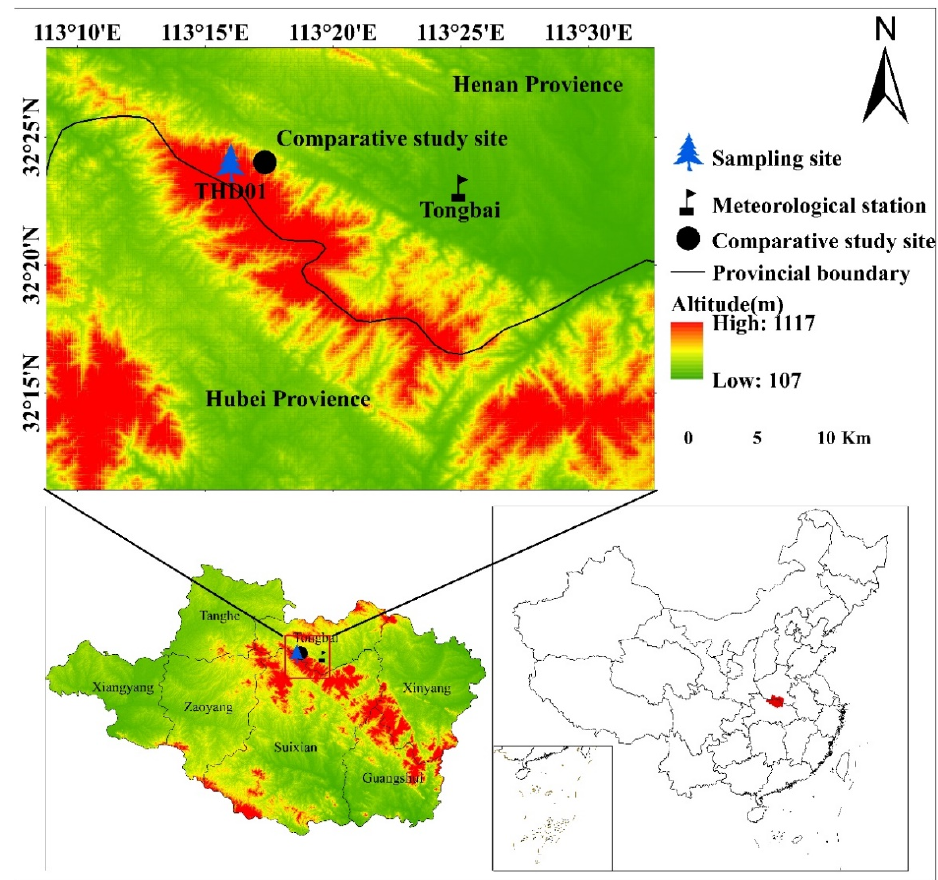
Figure 1. Location map of sampling site, comparative study site and nearby meteorological stations.